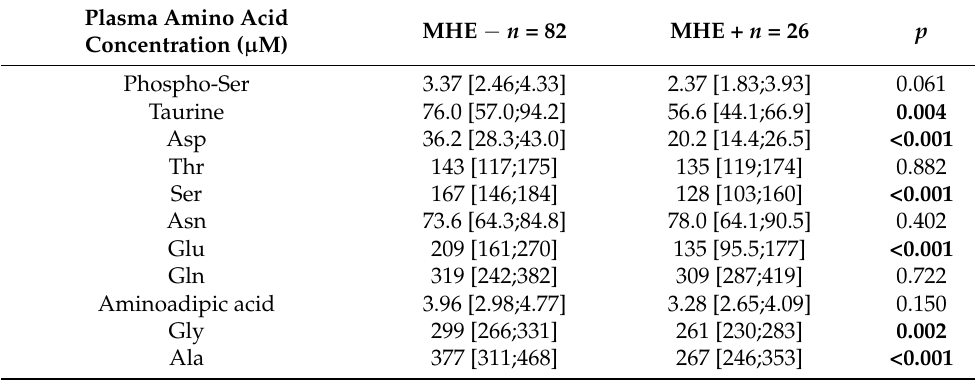
Table 4. Association between plasma amino acid levels and minimal hepatic encephalopathy in all cirrhotic patients